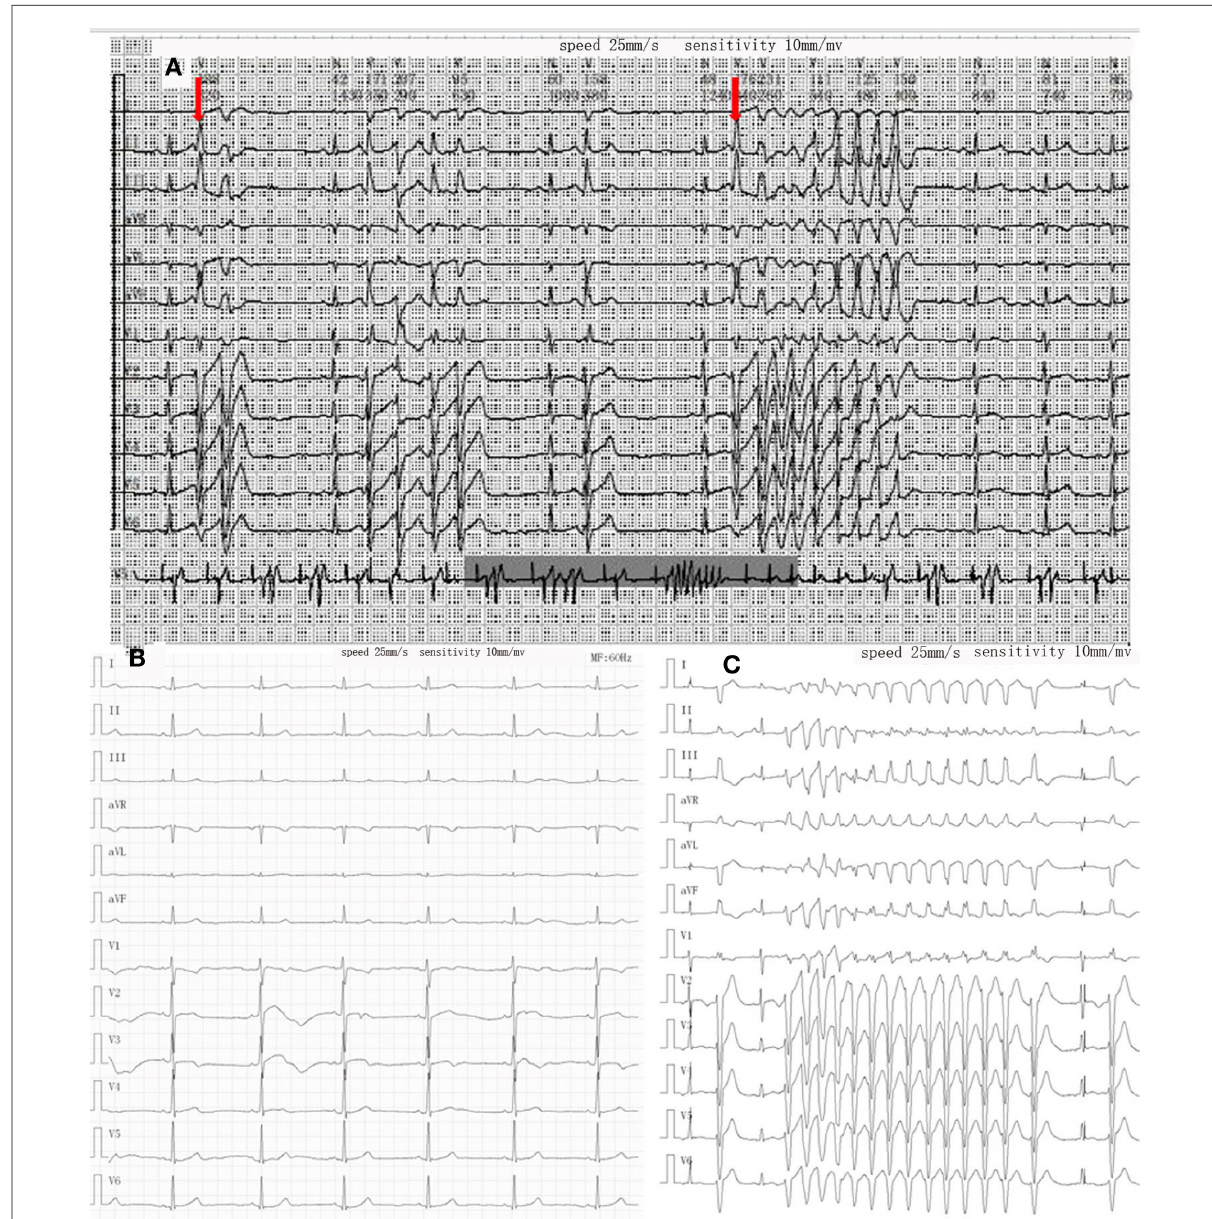
FIGURE 1 Changes in ECG during treatment. ( A ) Holter on admission showed R on T phenomenon (red arrow) and torsades de pointes. ( B ) After treatment of propranolol and magnesium sulfate, the QT interval was in the normal range, and no obvious ventricular premature beats were found. ( C ) Recurrence of torsades de pointes episode during oral